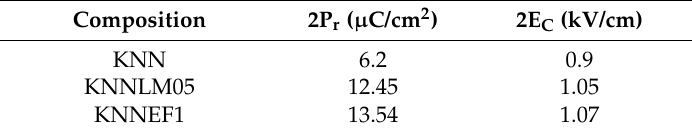
Table 3. Remnant polarization (2P r ) and the coercive field (2E c ) for sintered ceramics.